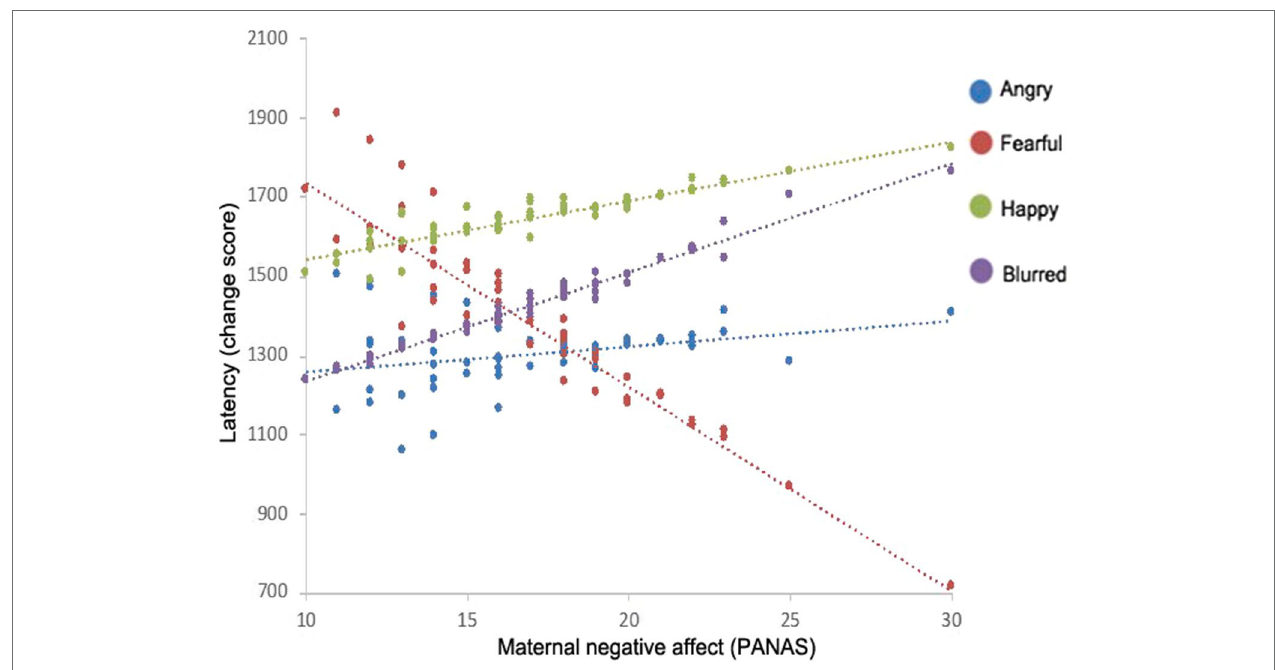
FIGURE 4 | Interactions between maternal negative affect and the latency to find the target on the visual search task for each face